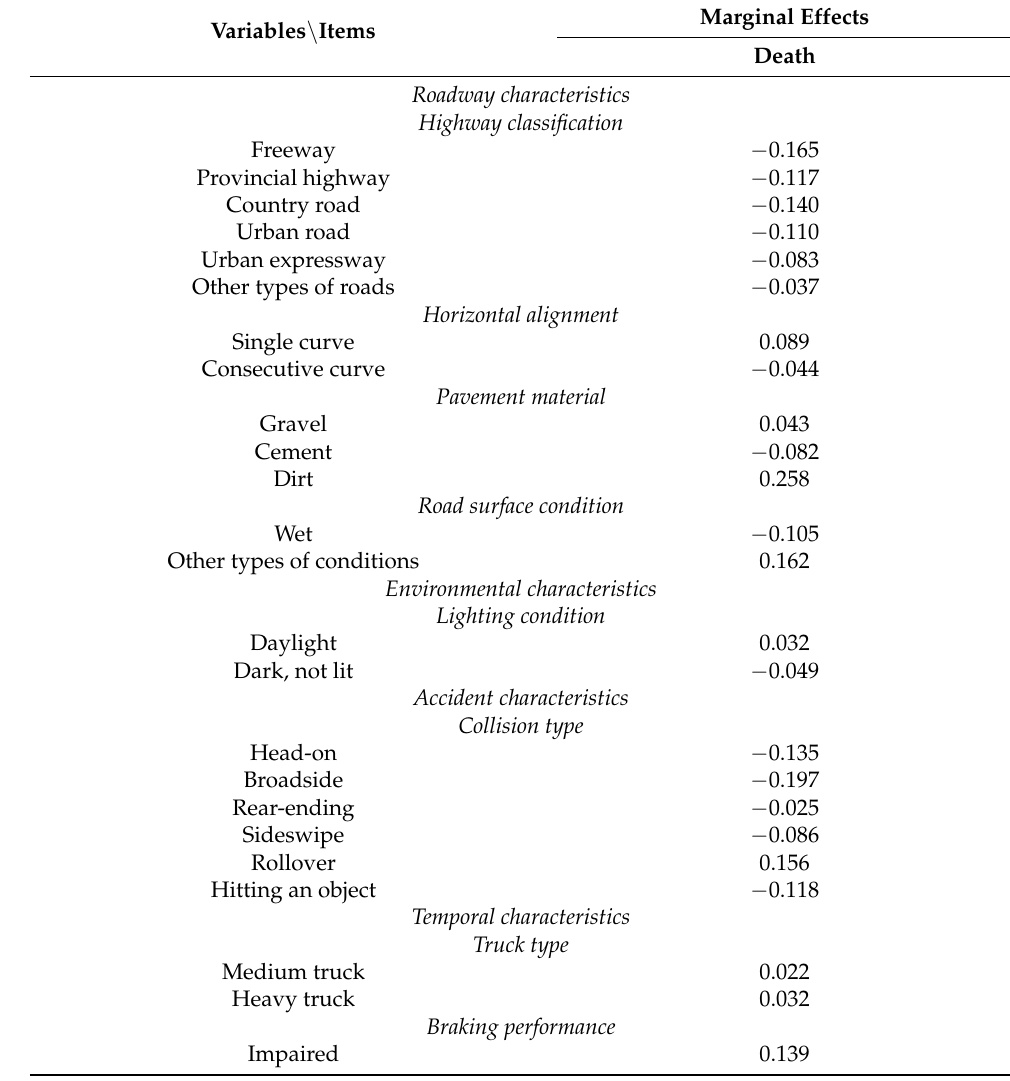
Table 3. Marginal effects for the random parameter logit